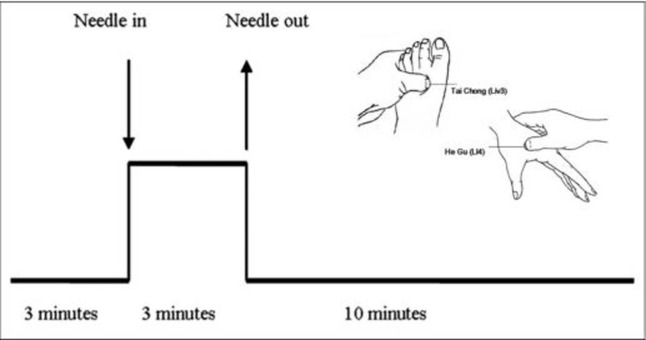
Protocols for acupuncture.